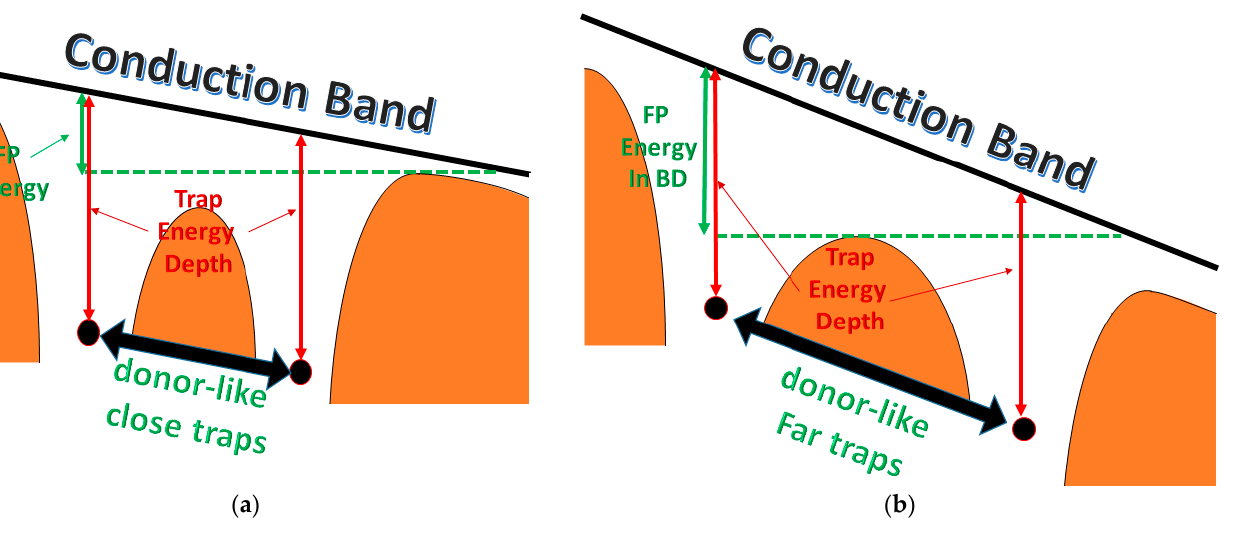
Figure 9. ( a ) FP energy in standard materials with high density filled traps with reciprocal coulombic interaction with highlighted barrier lowering. ( b ) FP energy in quasi-ENZ BD surface.